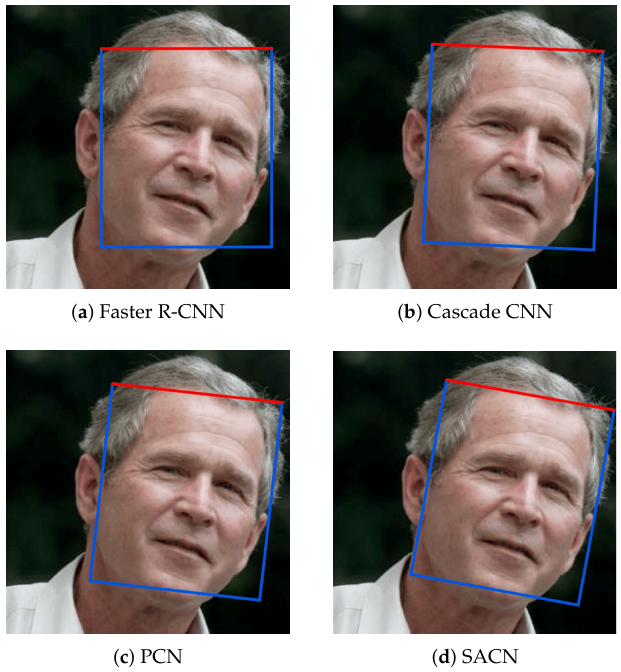
Figure 10. The detecting results of Faster R-CNN, Cascade CNN, PCN, and